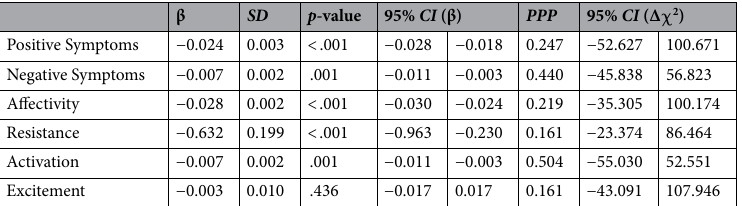
Table 3. Linear regression analysis comparing trait components of CHRS and FEP individuals. CHRS Clinical High-Risk State, FEP First Episode Psychosis, ß standardized regression coefficient, SD standard deviation, CI confidence interval, PPP posterior predictive p -value, Δ χ 2 difference between the observed and the replicated chi-square